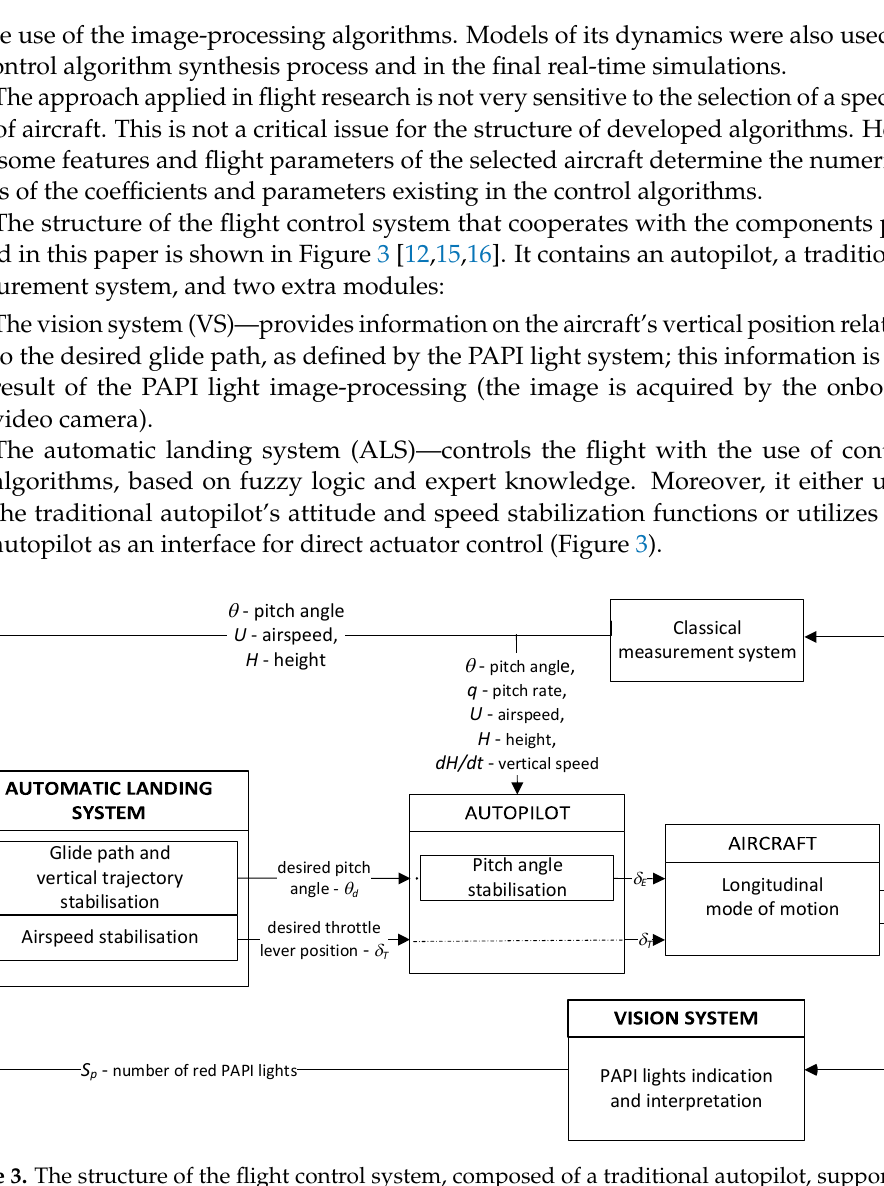
Figure 3. The structure of the flight control system, composed of a traditional autopilot, supported by an automatic landing system and vision δ E , δ T − the elevator position and throttle lever position are control signals affecting the aircraft [12].